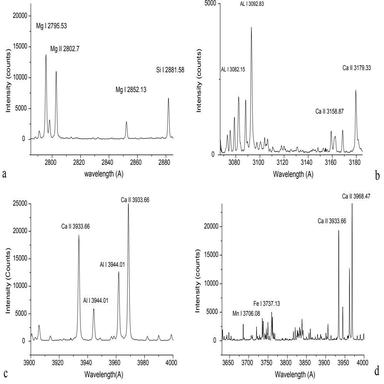
LIBS analysis of the clay sample.